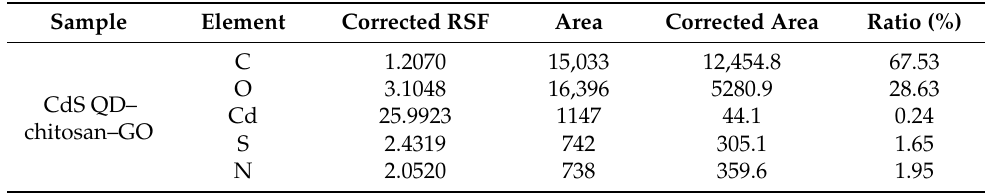
Figure 2. XPS narrow scan spectra of PAR–chitosan–GO for ( a ) C 1s; ( b ) O 1s; and ( c ) N 1s. Table 2. Elemental composition of the CdS QD–chitosan–GO thin